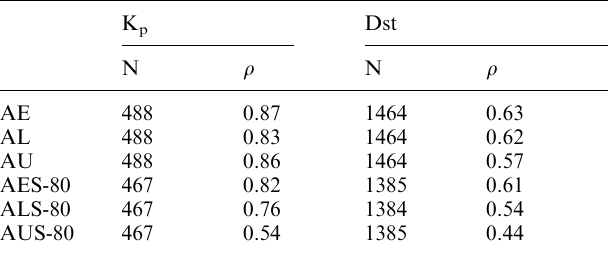
Table 2. Number of data points (N) and correlation coe(cid:129)cients ( q ) between the indicated parameters